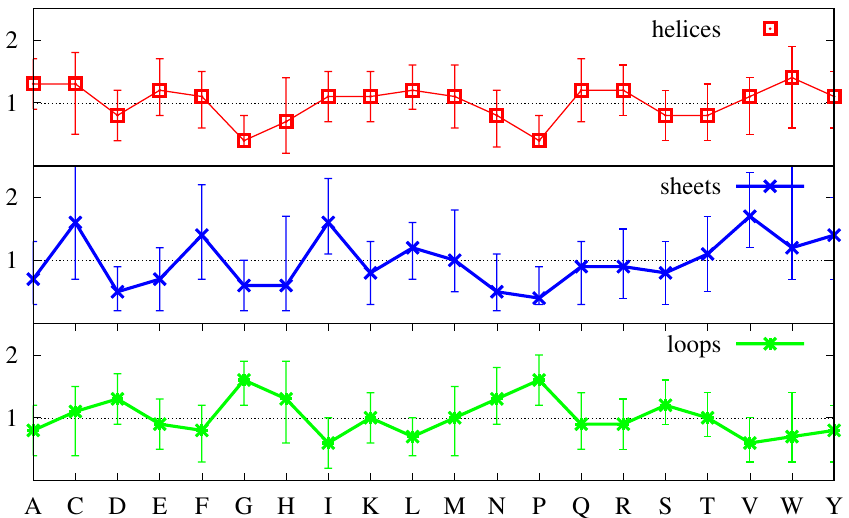
Figure 6. Most probable values for the ratios R ( a , s , p ) (cf. Equation (10)) for α -helices ( top plot , red), β -sheets ( middle plot , blue) and loops ( bottom plot , green). The most probable value is taken from the middle peak in the distributions for each ratio R ( a , s , p ) and the uncertainty around that value is given by the FWHM of that middle